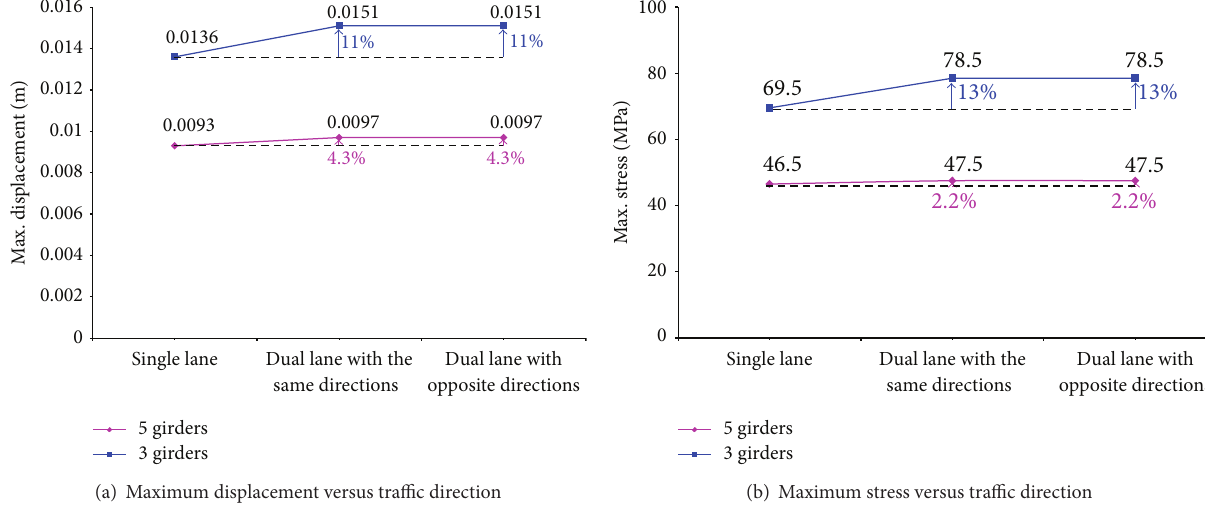
Figure 12: Schematic of dynamic responses of unstrengthened composite